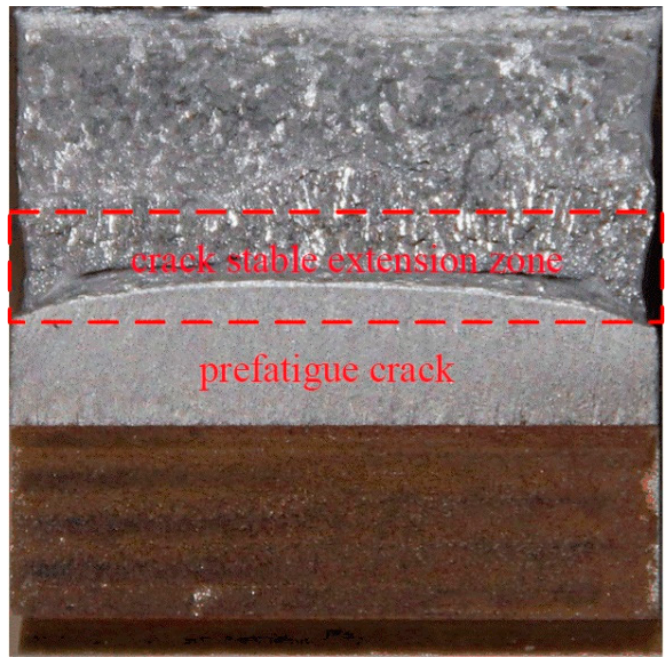
Figure 8. Location of the cloud image analysis of the fracture front of the prefabricated fatigue crack.